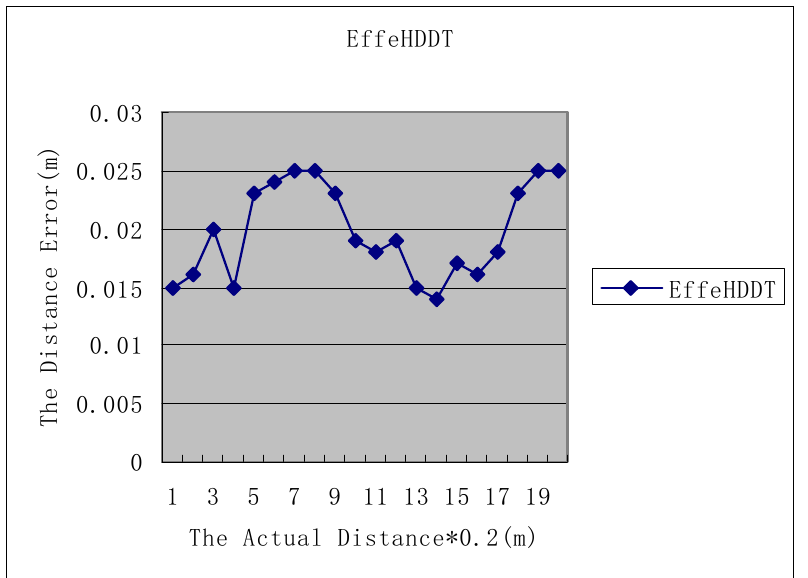
Figure 8. The distance error of EffeHDDT.